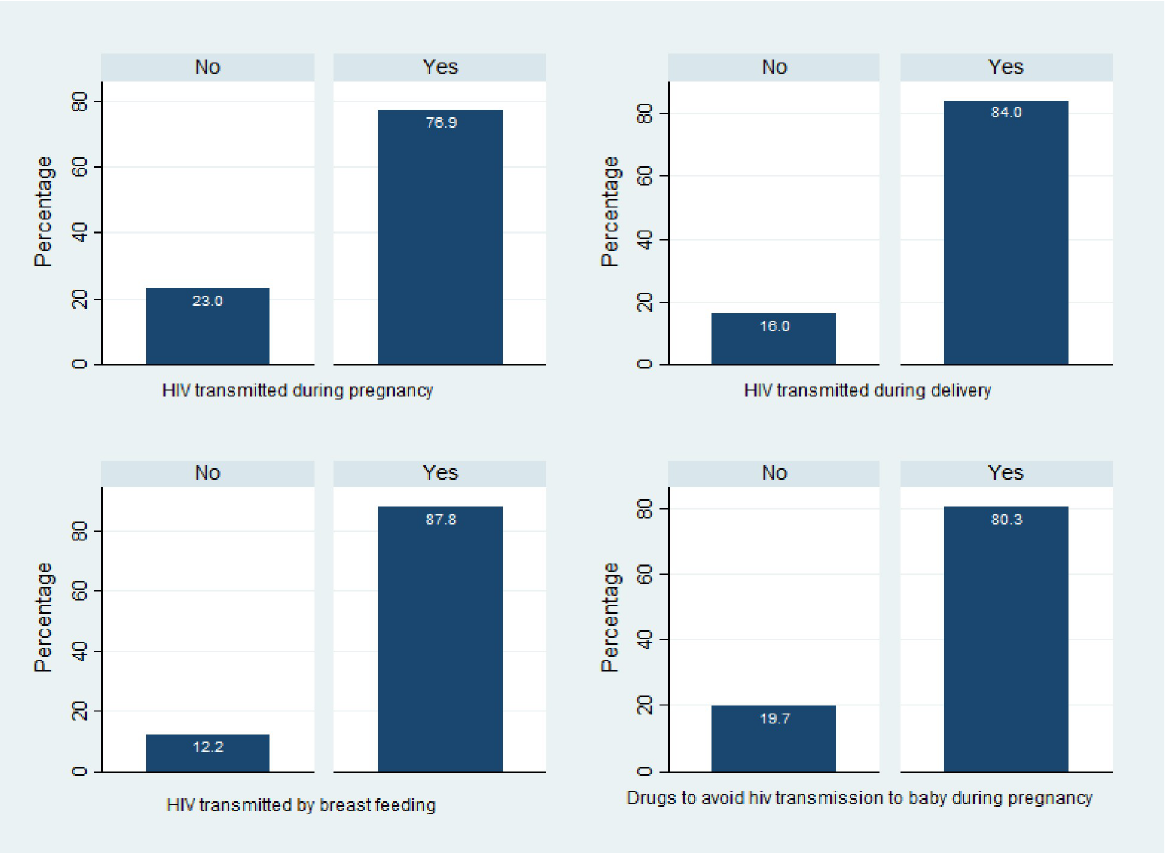
Fig 1. Percentage of Ethiopian reproductive-age women who know mother-to-child HIV transmission routes, 2016 EDHS.